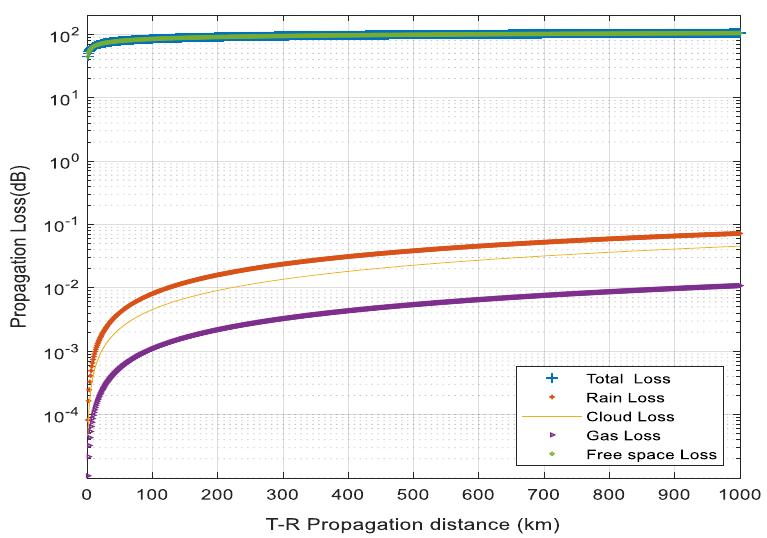
Figure 11. Plot of propagation loss due to attenuation from atmospheric variables.